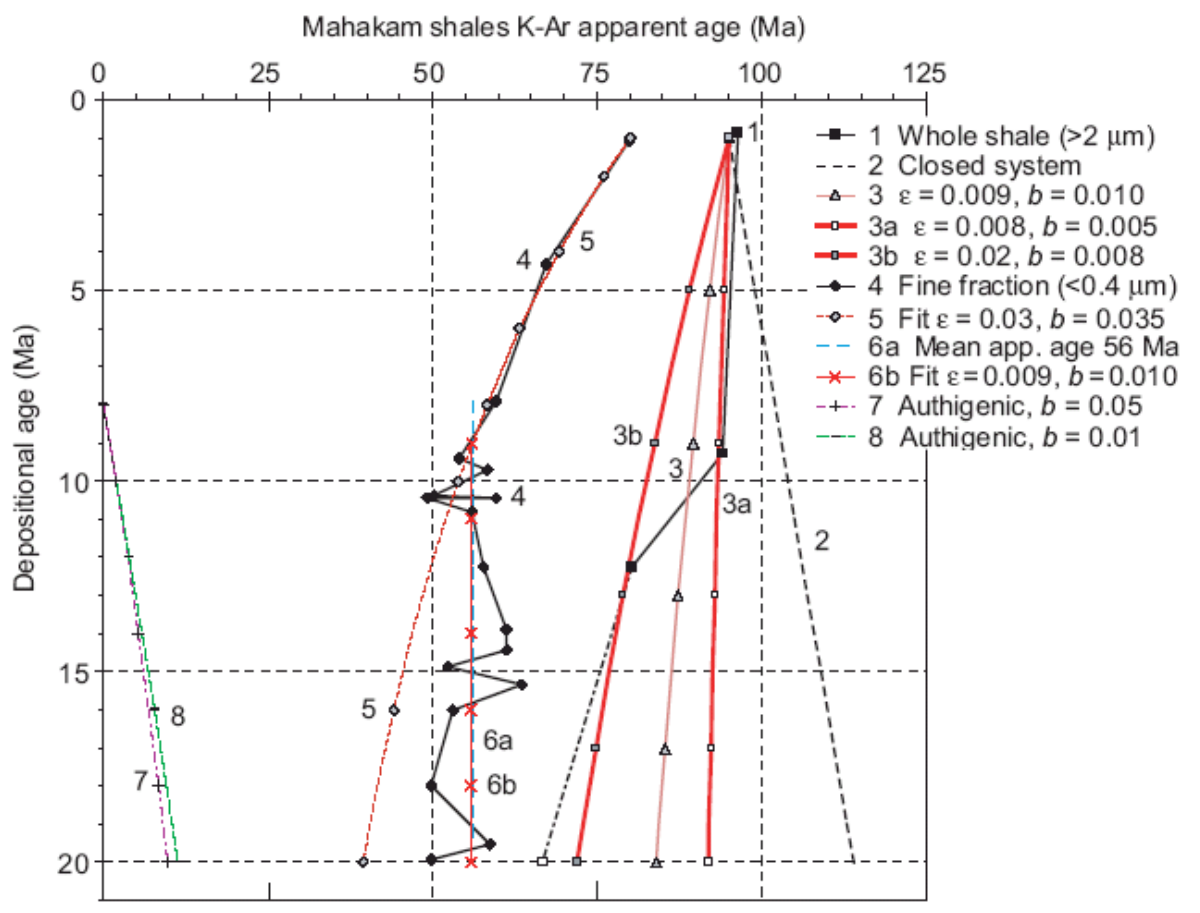
Figure 6. K-Ar apparent age of the coarse- (line 1) and fine-grained (line 4) fractions of the Mahakam shales, calculated from the two-process model of 40 Ar loss and K gain at different rates. For the coarse fractions: calculated K-Ar data if the particles were a closed system (line 2); simultaneous 40 Ar escape and K addition (bracketing the data points (curves 3a, 3b) and an approximate mean (curve 3). For the fine-grained fractions: depositional age 1–8 Ma, 40 Ar escape and K addition (line 5); 8–20 Ma, mean apparent age constant (curve 6a), and the calculated fit for 40 Ar escape and K addition (curve 6b). Computed authigenic particles growth by addition of K (curves 7 and 8) at different rates, starting at depositional age 8 Ma. See Equation (A4b) in the Appendix A.